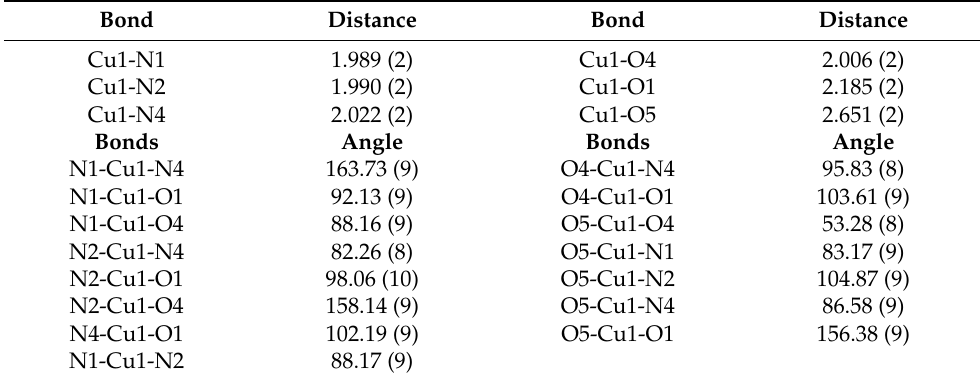
Figure 3. Structure and atomic numbering of complex 1 . The disordered ethanol molecule was omitted for better clarity. Table 1. The most important bond distances (Å) and angles (˚) of complex 1 .